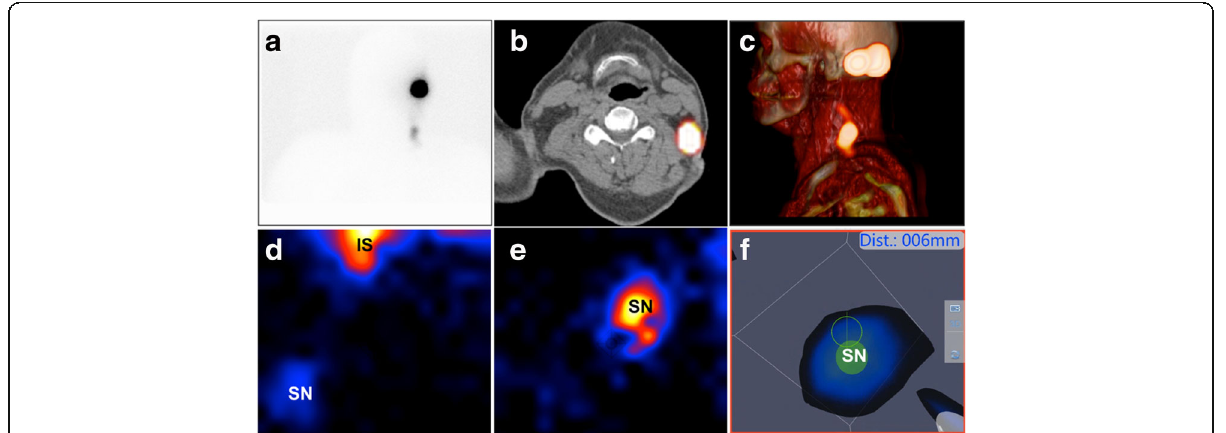
Fig. 1 Overview of the acquired images. a Example of an anterior lymphoscintigram showing a clear sentinel node in the neck. b , c SPECT/CT imaging of the patient shown under a allowed placement of the hotspot in its anatomical context with the sentinel node being located in level V. The fused SPECT/CT images provided the surgeon with an anatomical roadmap for planning of the surgical procedure. d 2D mobile gamma camera image acquired in the operation room showing a sentinel node (SN) and the injection site (IS). e Zoom-in of the image shown in d . f A free- handSPECT scan was acquired and subsequently the gamma probe was navigated, in augmented reality, to the sentinel node as seen in the freehandSPECT